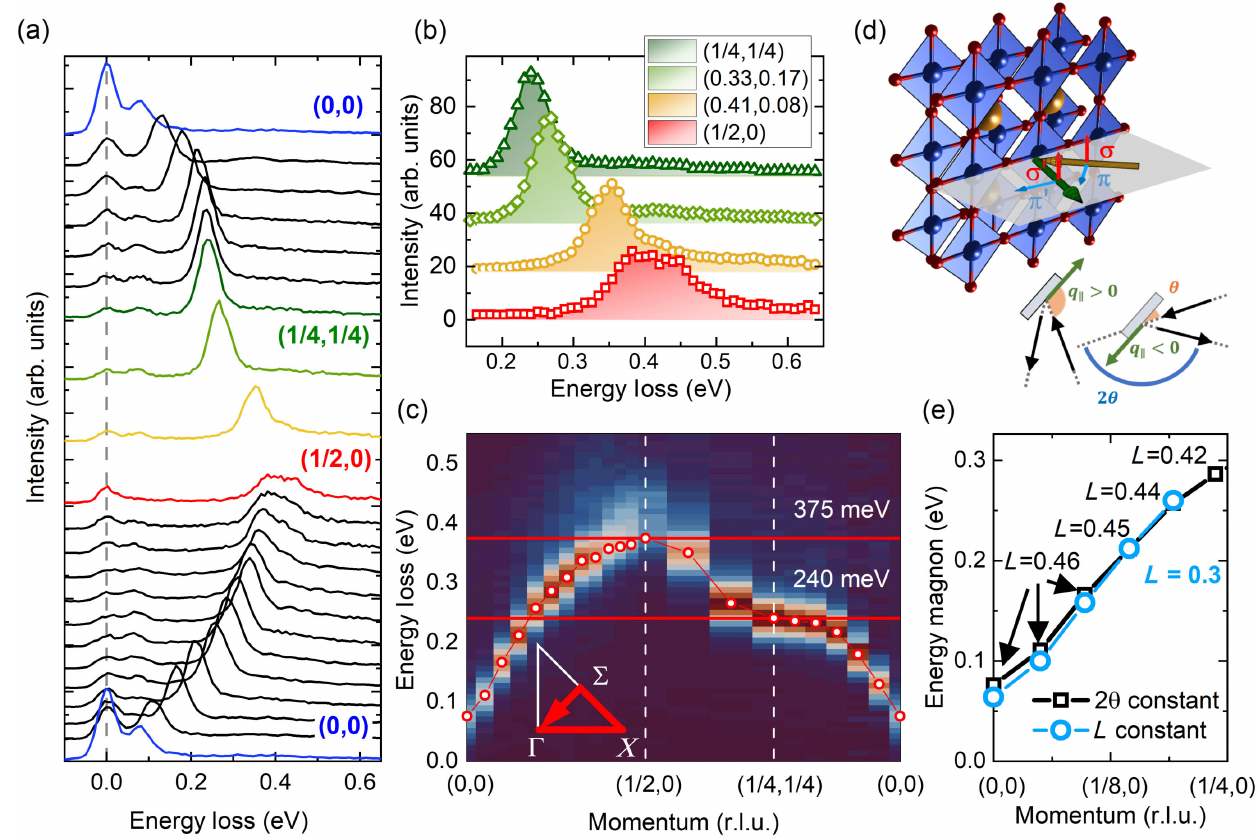
FIG. 2. (a) RIXS scans at different momenta, acquired in grazing-out geometry and π polarization. (b) Evolution of RIXS spectra along the Σ → X line. Scans have been normalized to the spin-flip cross section. (c) Measured dispersion of the magnon peak along the high-symmetry lines of the Brillouin zone illustrated in the inset. The red dots corresponds to the energy extracted by fitting the experimental data (error bars are smaller than the size of the dots). The two red horizontal lines highlight the magnon energy at ( π ,0) and at ( π = 2 , π = 2 ). (d) Sketch of CaCuO 2 crystal structure and experimental geometry used in the RIXS experiments, also showing the incident and outgoing polarization of light. Cu atoms are blue, oxygen atoms are red, and Ca cations are gold. Polarization perpendicular to (lying in the) scattering plane is labeled σ ( π ). The small inset is a scheme of grazing-in and grazing-out geometries. The shaded orange area represents the incident angle, the scattering angle 2 θ is depicted in blue, while the green arrows depict the component of the in-plane transferred momentum. (e) Energy of magnetic excitations along the Γ → X line measured with constant scattering angle (black squares) and constant L (light blue circles). Note that L values at each point are reported. The incident polarization is π , and we employ grazing-out